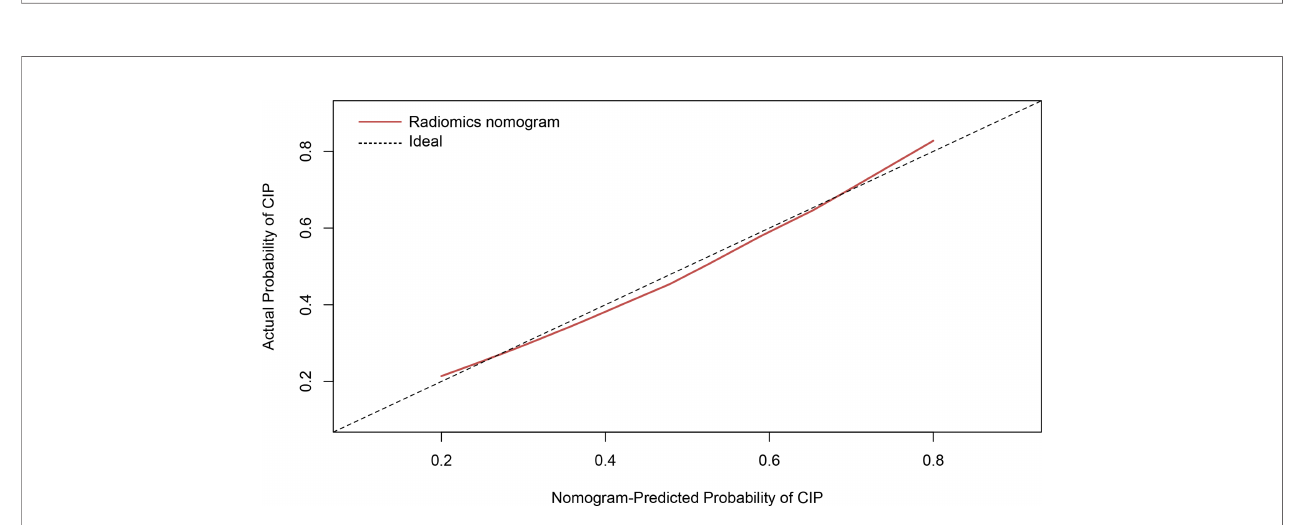
FIGURE 7 | Calibration curve of the radiomics nomogram presented as a solid red line. The diagonal dashed line indicates perfect agreement.